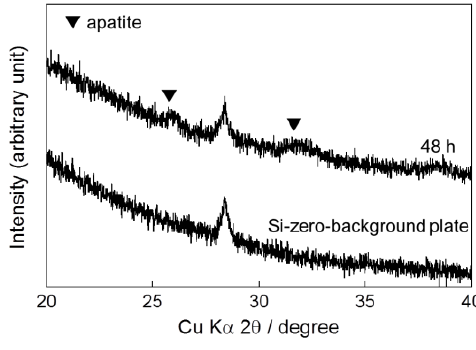
Figure 3. XRD pattern of calcium phosphate deposited on the Ti pin after immersion in the CaP solution at 25 °C for 48 h and that of a silicon-zero-background plate.